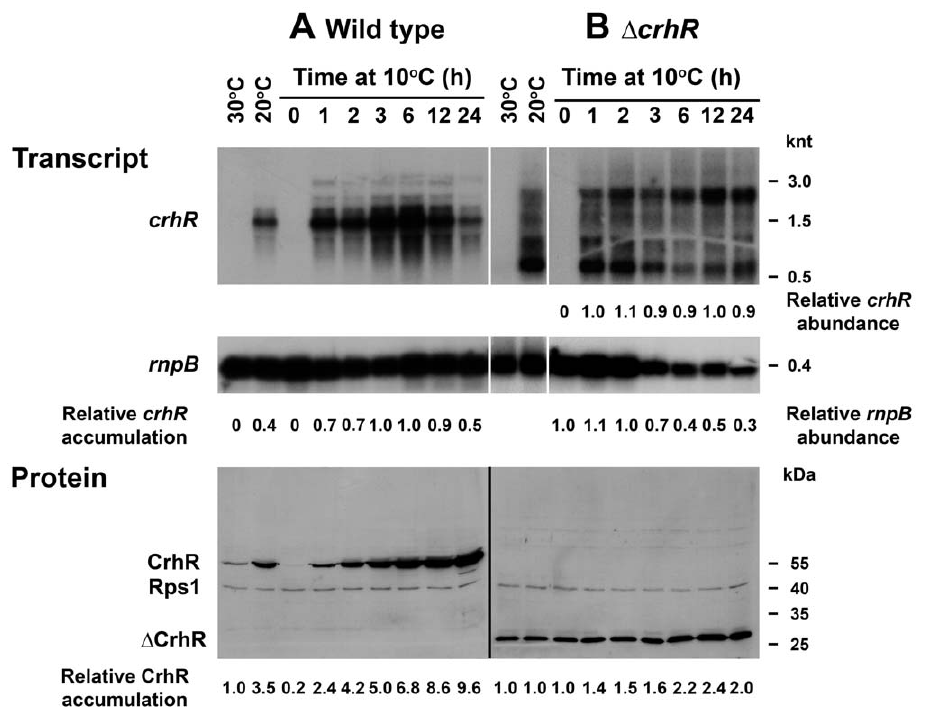
Figure 7. Time course of crhR expression at 10 u C. Wild type ( A ) and D crhR ( B ) Synechocystis were grown to mid-log phase at 30 u C and transferred to 10 u C for the indicated times. Samples were harvested for RNA and soluble protein extraction at the indicated time points. Cells grown at 30 u C and 20 u C are included as references. ( A ) The relative crhR accumulation in comparison with the abundance in illuminated, wild type cells grown at 30 u C corrected for rnpB levels (set to 1.0), is given below each lane for wild type cells. For D crhR cells, decreasing rnpB accumulation necessitated calculation of the relative abundance of crhR and rnpB independently. Transcript levels at 1 h of exposure to 10 u C and 0 time were set to 1.0 for crhR and rnpB , respectively. Quantification of the 2.3 and 0.75 knt transcripts is shown in Table S1. ( B ) Western blots were simultaneously probed with antibodies against CrhR and E. coli Rps1 that served as a control for protein loading. The relative fold change in CrhR and D CrhR accumulation, corrected for Rps1 levels, as described in Methods S1, is given below each lane. Protein samples were resolved on separate gels, hence normalization was performed independently for the wild type and mutant, with abundance observed in wild type and mutant at 30 u C set to 1.0.